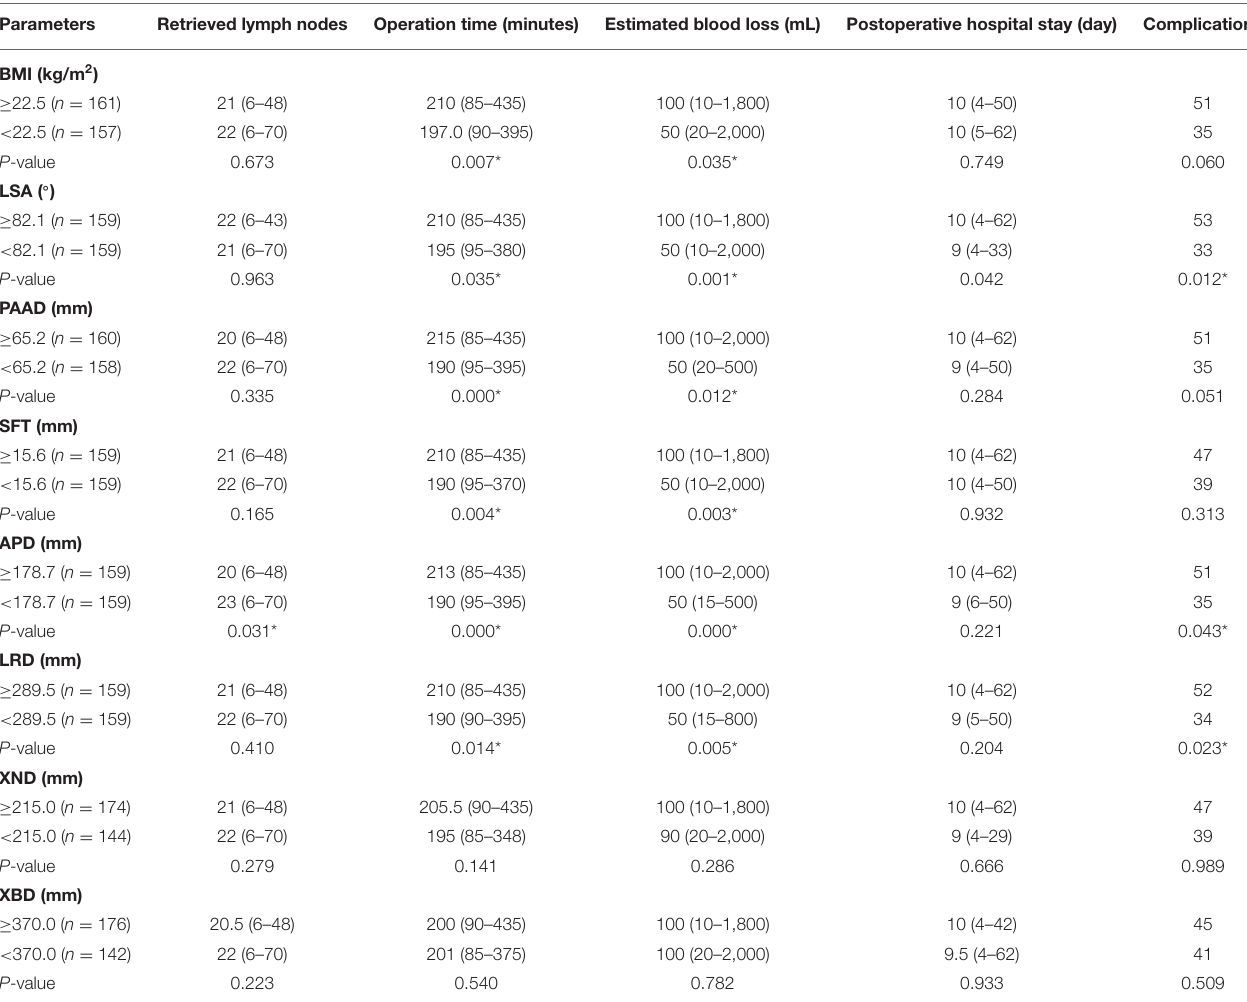
TABLE 3 | Short-term surgical outcomes in male patients ( n =